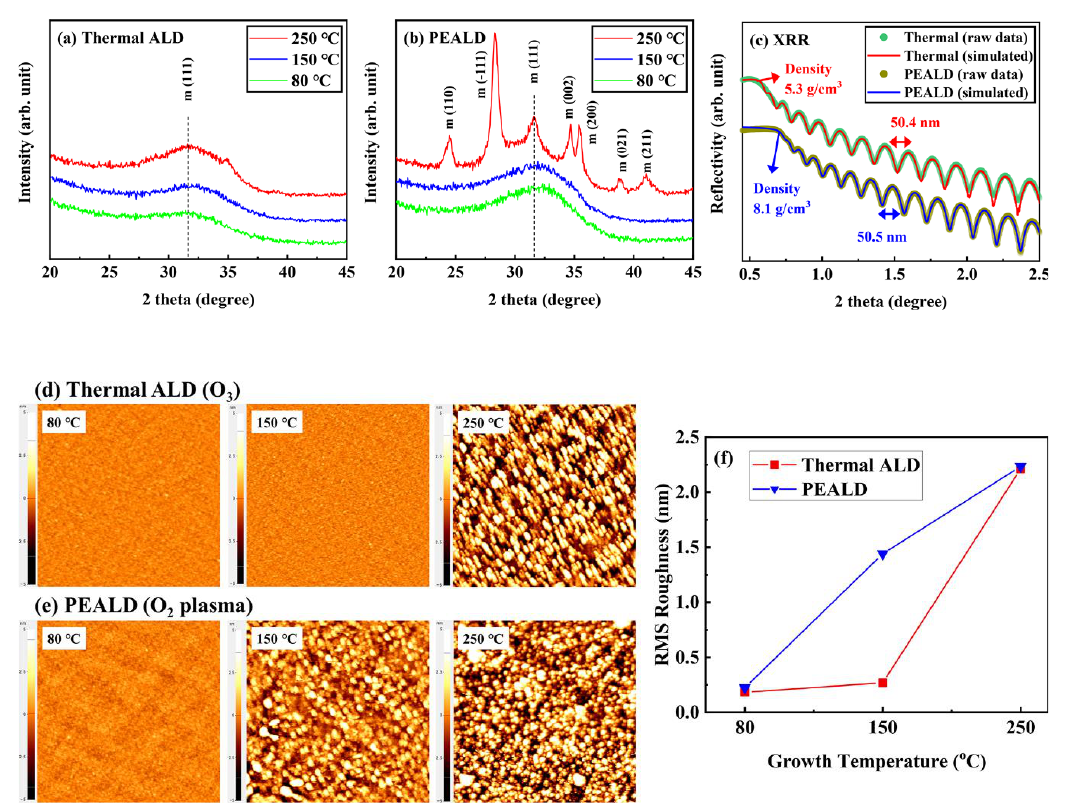
Figure 2. ( a , b ) XRD pattern in HfO 2 thin films (50 nm) deposited at 80 – 250 °C by thermal ALD and PEALD, measured by GIXRD. ( c ) Density of HfO 2 thin films (50 nm) formed at 80 °C by thermal ALD and PEALD, measured by XRR. ( d , e ) AFM topography images of HfO 2 thin films (50 nm) deposited by thermal ALD and PEALD. ( f ) Root mean square (RMS) roughness of HfO 2 by growth temperatures (80 – 250 °C).